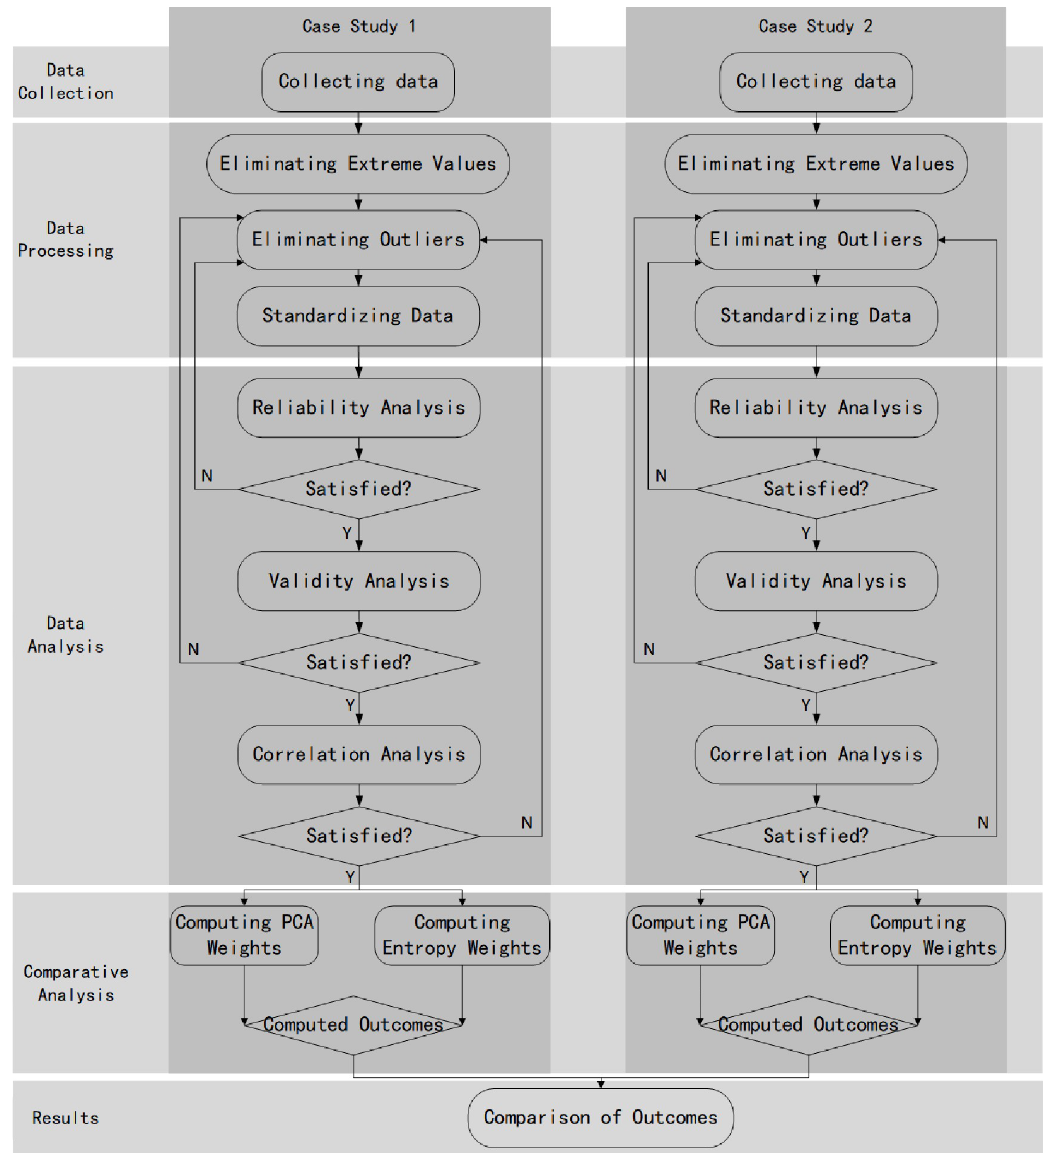
Fig 1. The research procedure